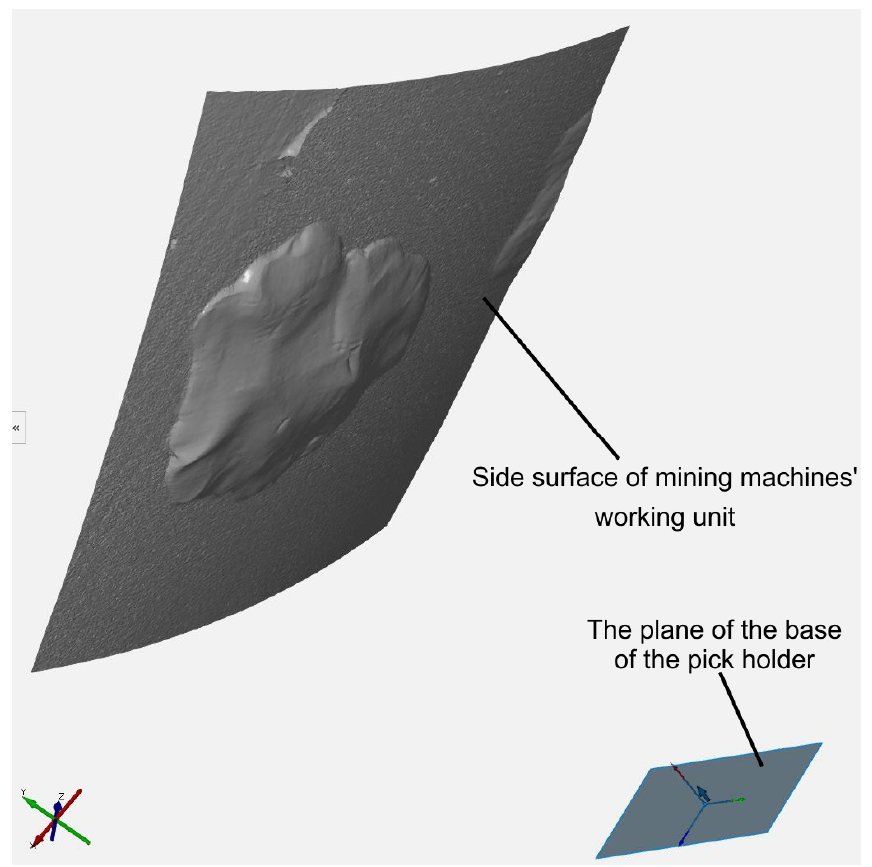
Figure 21. Spatial orientation of the pick holder base plane relative to the cutting head side